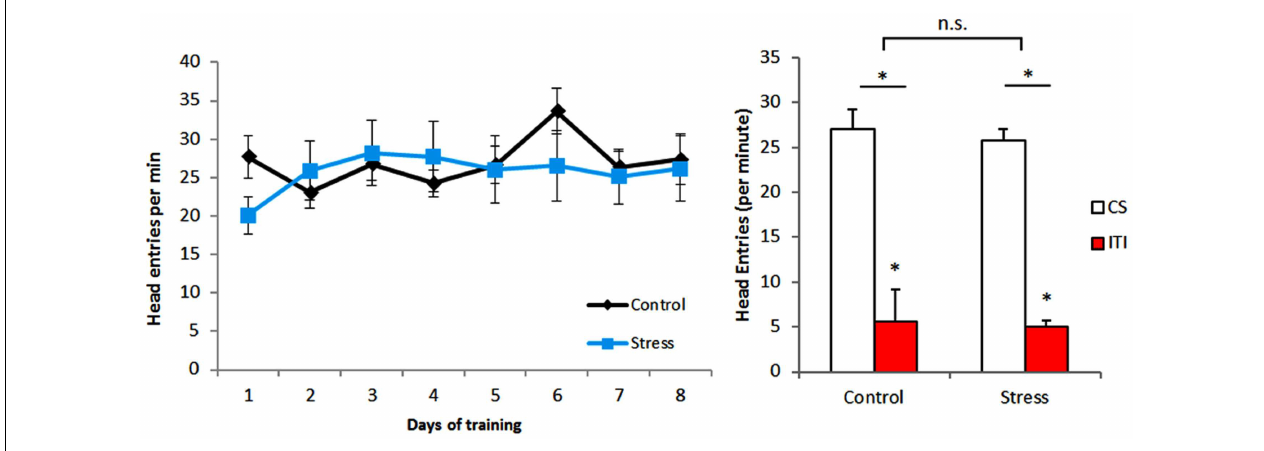
conditioned stimulus exposure. ITI – intertrial interval between presentations of conditioned stimuli CS – conditioned stimulus.* p <